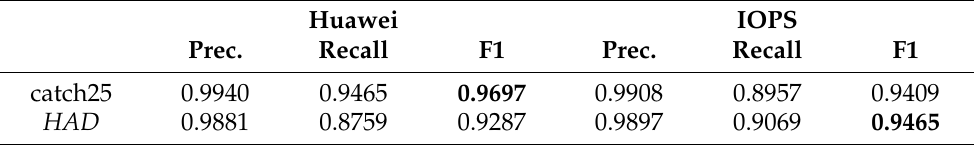
Figure 5. HAD feature importance for Random Forest on IOPS dataset. Table 7. Mean F1 Recall and Precision of the Random Forest model on the Huawei and IOPS datsets using the catch25 and HAD feature sets, respectively. Bold font indicates highest F1 on a